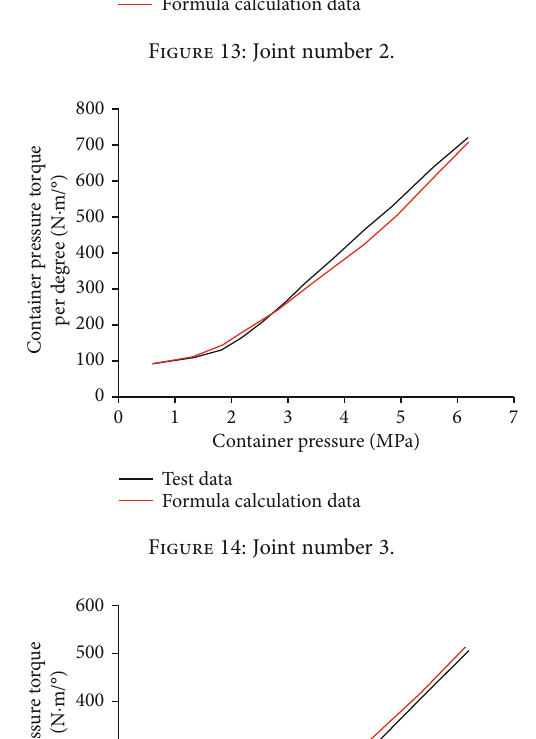
Figure 14: Joint number 3.